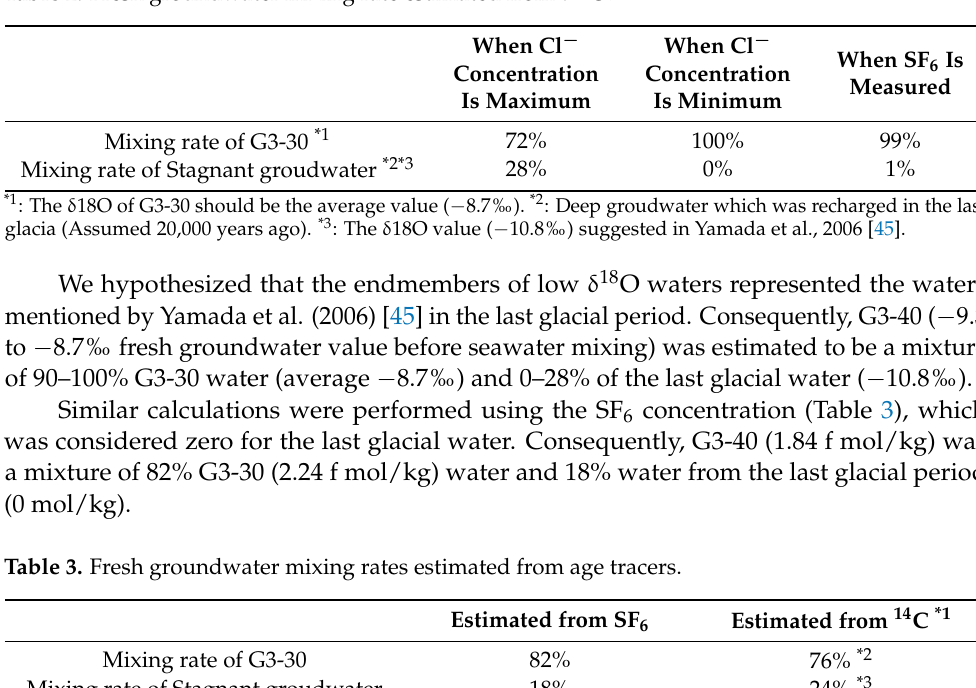
Table 2. Fresh groundwater mixing rate estimated from δ 18 O.